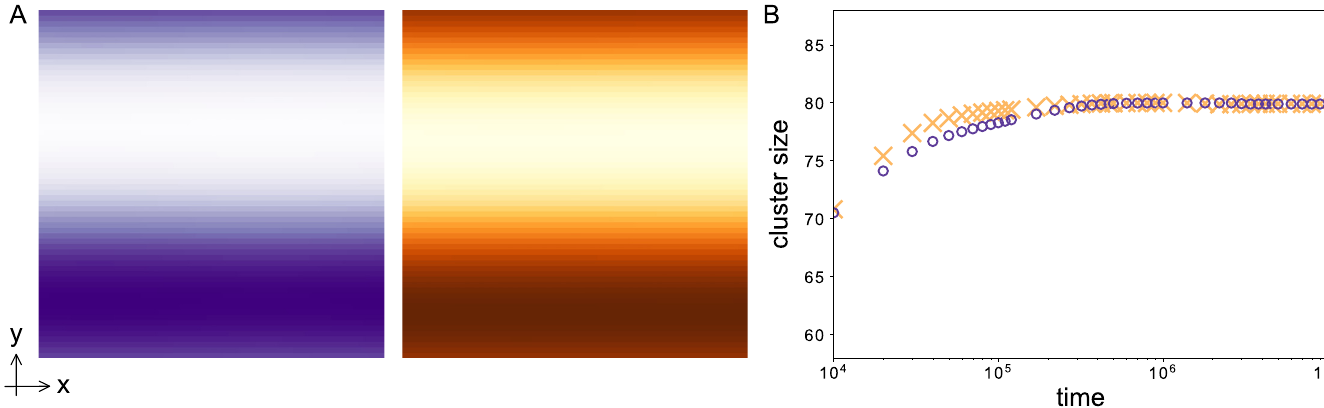
Fig 5. Coarsening is suppressed in small systems. (A) 2D snapshots of the full model (left, purple) and the corresponding CH model (right, orange) for t = 5 � 10 6 in a small system ( L = 80). Both simulations show a fully phase separated (one peak) system. (B) Cluster size as a function of time for the polarization model (purple circles) and the corresponding CH model (orange crosses). The cluster size almost immediately goes to the system size L = 80. Parameters: a 2 = 2, ε = 0.01.